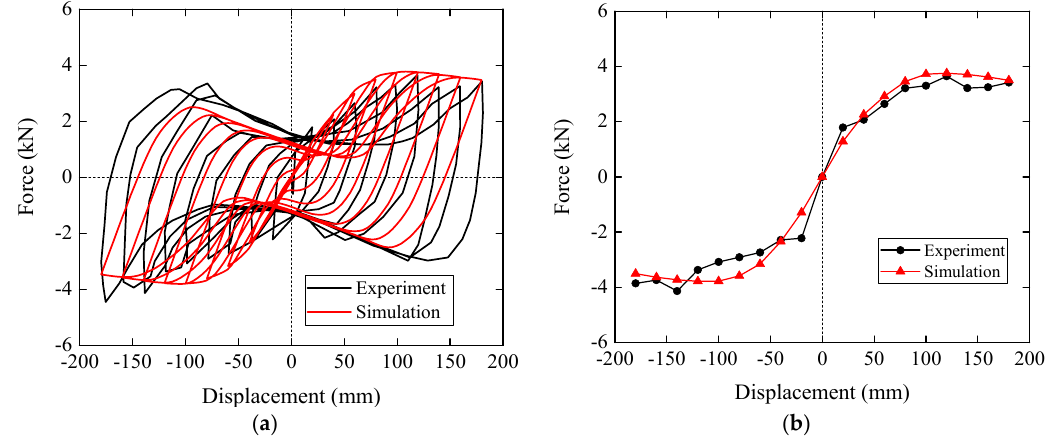
Figure 8. Results of the experiment and the simulation: ( a ) Hysteresis curves; ( b ) Skeleton curves.